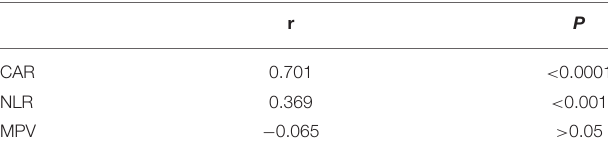
TABLE 3 | Correlation between the CAR, NLR, and MPV and BVAS in AAV